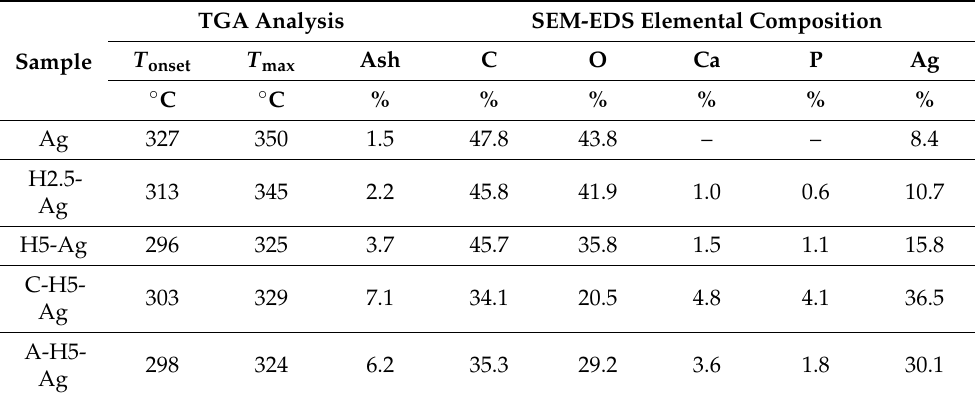
Table 1. Data extracted from the thermogravimetric analysis (TGA) and SEM-EDS analyses with elemental analysis of the cotton gauze